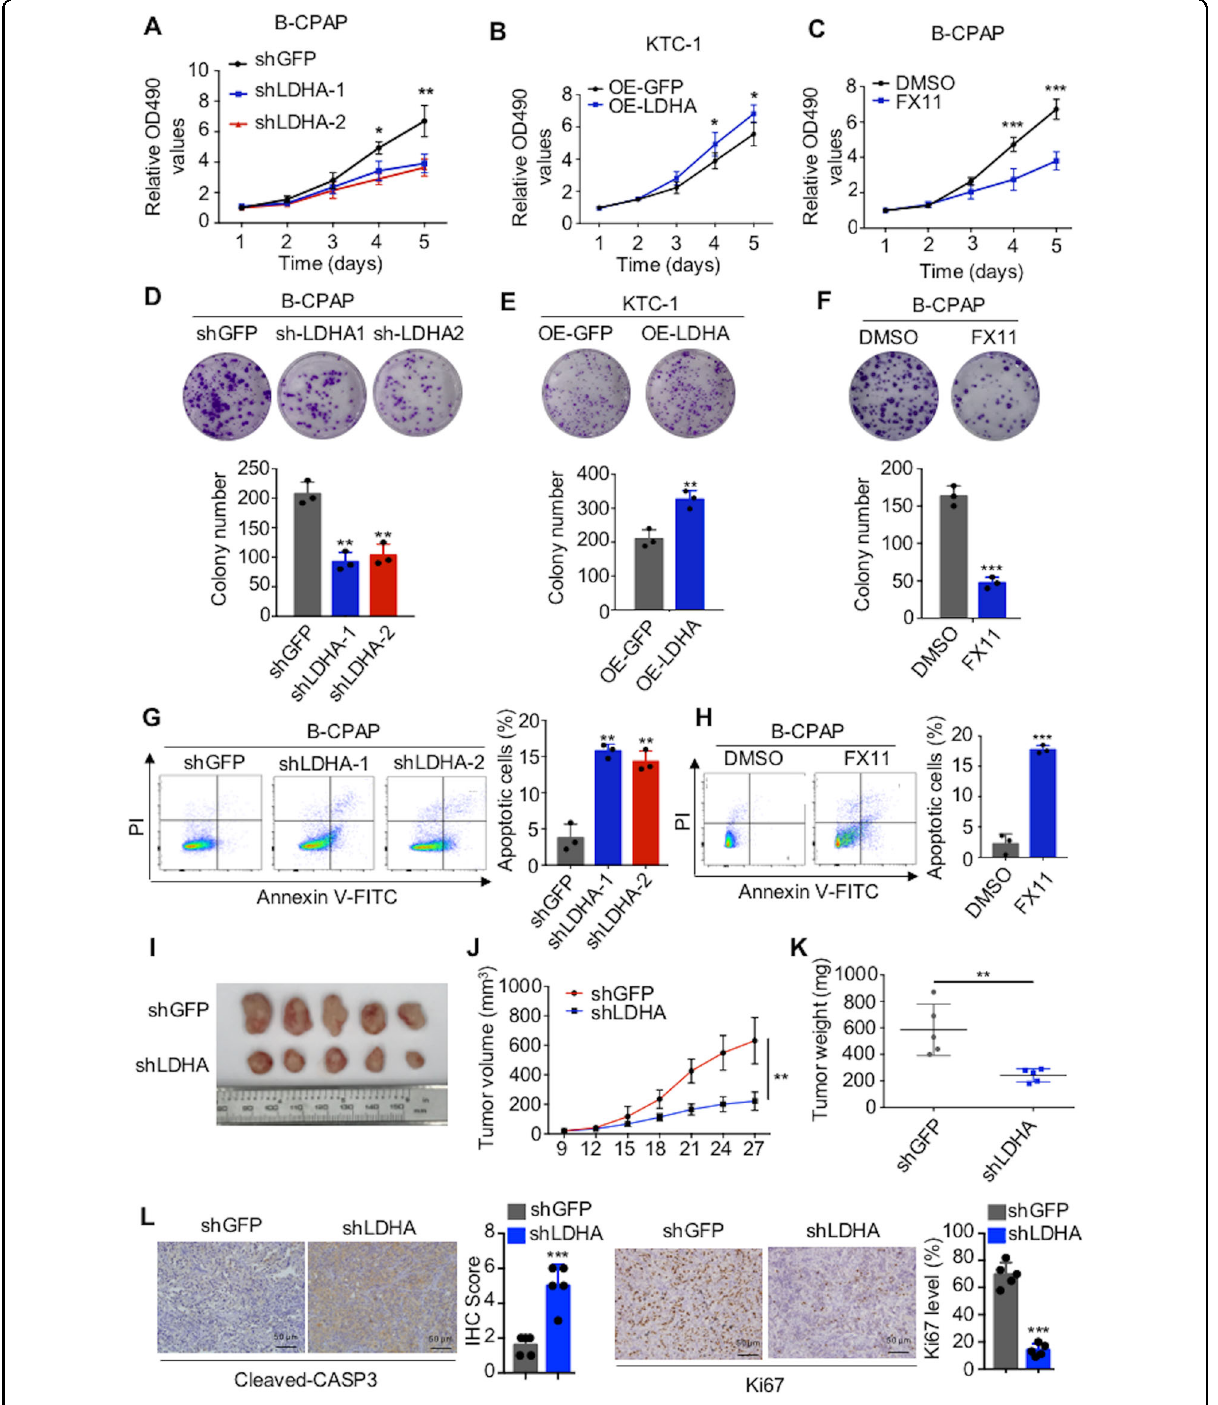
Fig. 4 LDHA promotes the proliferation and inhibits the apoptosis of PTC cells in vitro and in vivo. A – C CCK-8 assays and D – F colony formation assays showed that LDHA knockdown or inhibition signi fi cantly suppressed cell proliferation in B-CPAP cells and that the overexpression of LDHA promoted cell proliferation in KTC-1 cells. G , H Flow cytometry indicated that LDHA knockdown or inhibition signi fi cantly induced cell apoptosis in B-CPAP cells. I Five representative tumors from LDHA knockdown cells are shown. Tumor volumes J are presented with growth curves, and tumor weights K were measured. L Representative IHC images of cleaved caspase 3 expression and Ki-67 staining in xenografted tumor specimens of control and LDHA knockdown mice are shown. The data are presented as the mean ± SD. All * p < 0.05, ** p < 0.01, *** p <